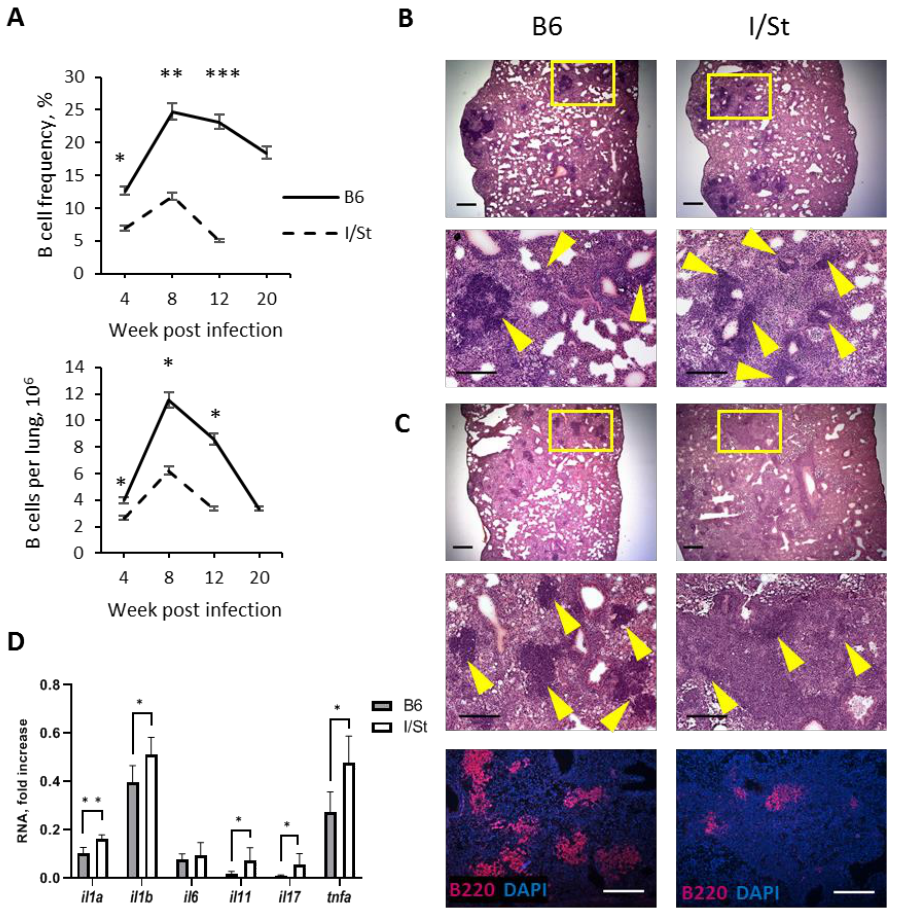
Figure 1. A decrease in number of lung B cells and BCFs coincides with development of diffuse inflammation in TB-susceptible I/St mice. ( A ) Dynamic of relative and absolute B-cell content in the lungs of I/St and B6 mice after M. tuberculosis H37Rv infection, FACS enumeration of CD19 + cells (percent from all lung cells). ( B , C ) Representative pictures of lung pathology in B6 and I/St mice at week 8 ( B ) and 16 ( C ) post-infection. Yellow arrows—B-cell follicles. Scale bar = 500 µ m. (( C ), lower panels) Visualization of B cells with anti-B220 mAbs. Scale bar = 500 µ m. ( D ) qrt-PCR evaluation of expression level of genes for inflammatory cytokines as measured in total lung mRNA of B6 and I/St mice at week 16 post-infection. Gene expression was normalized to that of hprt . Results of one of two similar experiments are displayed as mean ± SD, 4–5 mice per group per time-point. * p < 0.05; ** p < 0.01; *** p <